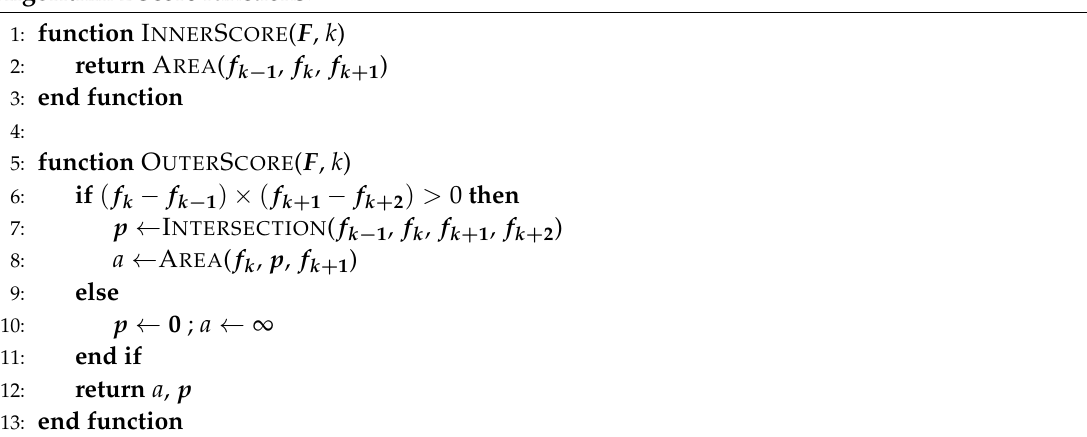
Algorithm 2 Score functions.